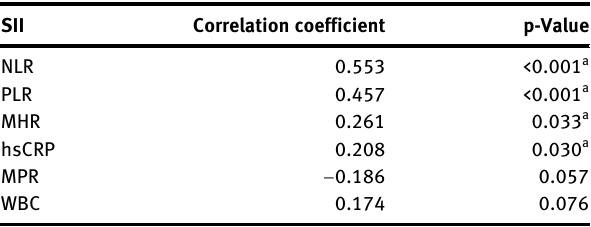
Table  : Spearman ’ s correlation analyses of systemic immune inf- lammation index with other in fl ammatory markers of patients with celiac disease.